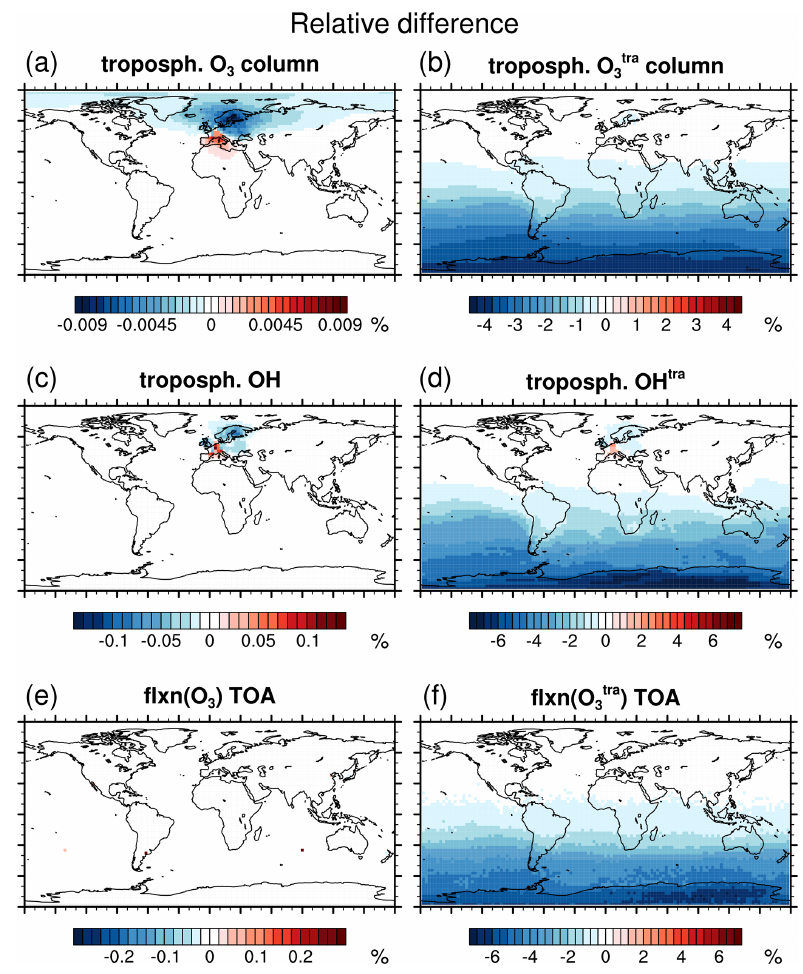
Figure 5. Relative difference between TransClim and EMAC simulation. Ozone (O 3 ), hydroxyl radical (OH) and ozone net radiative fluxes (flxn(O 3 )) as well as the contributions to ozone (O tra ), to hydroxyl radical (OH tra ) and to ozone net radiative fluxes (flxn(O tra 3 For O 3 and O tra , the relative difference of the tropospheric columns is shown ( a , b ). For OH and OH tra , the deviations of the tropospheric 3 means are displayed ( c , d ). The values at the top of the atmosphere (TOA) are shown for flxn(O 3 ) and flxn(O tra